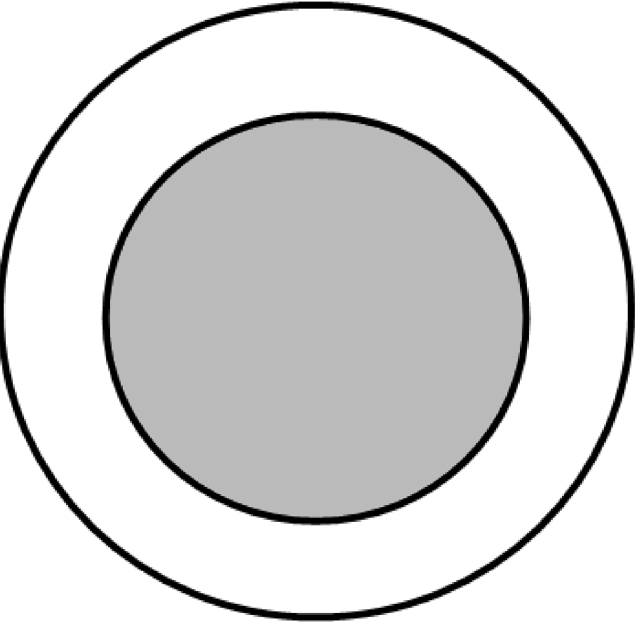
Fig 2. The inner and outer parts of the tree. Concentric circles represent an aerial view of a cross section through the canopy of the simulated tree, divided into two sections, the outer and the inner part of the tree with the same number of vegetation cubes in each of the two sections. The grey-coloured area represents the inner part of the